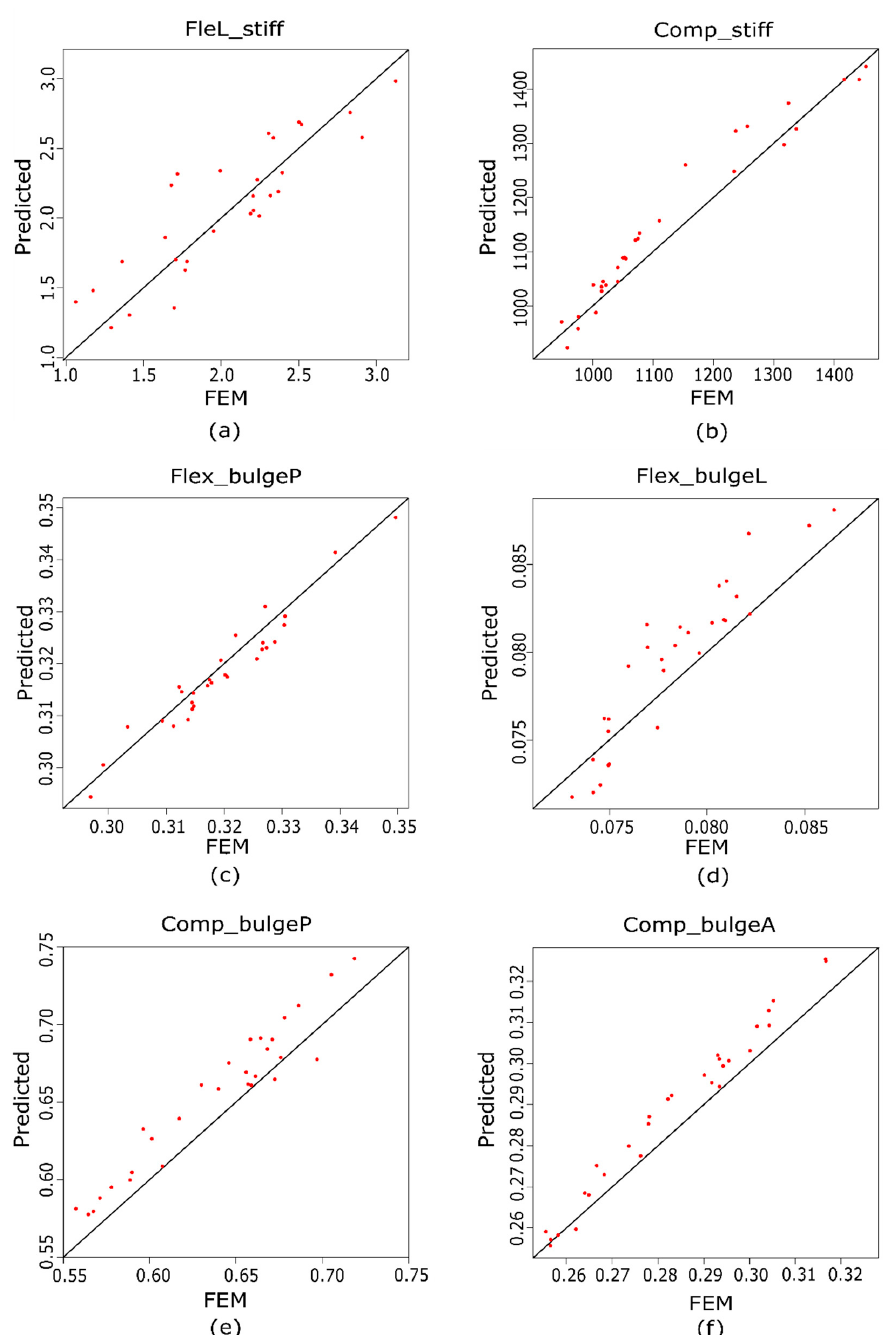
Figure 8 . Test scatter diagram of ( a ) lateral bending stiffness; ( b ) compression stiffness; ( c ) flexion bulge posterior; ( d ) flexion bulge lateral; ( e ) compression bulge posterior, and ( f ) compression bulge anterior.